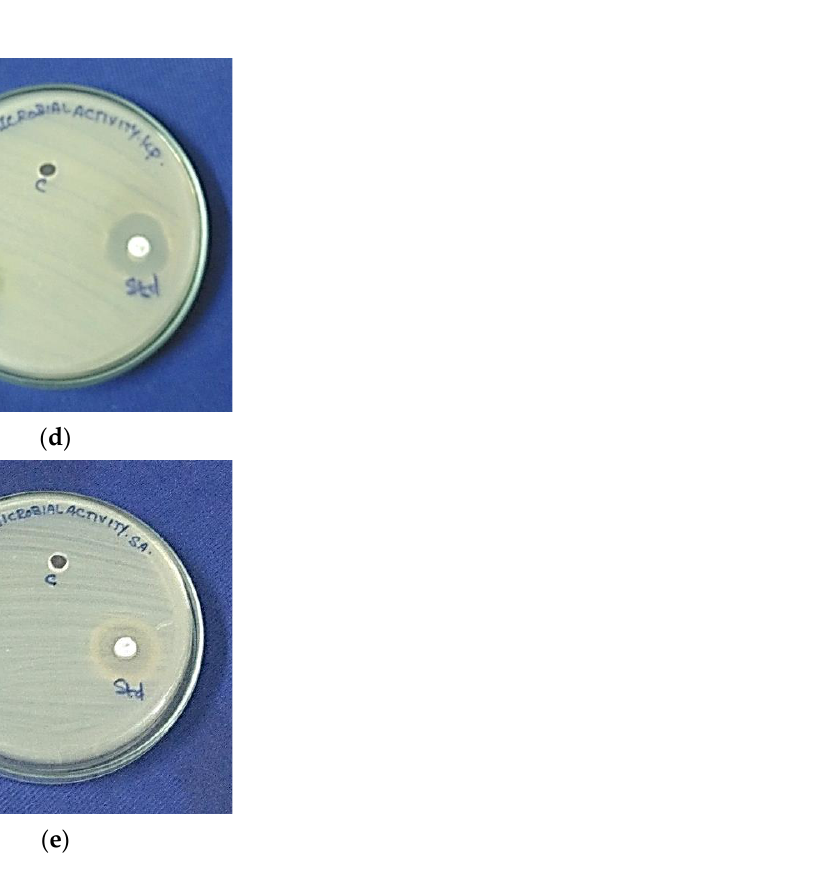
Figure 7. Antibacterial activity of Ni 2+ -doped HApNPs treated against ( a ) S. flexneri , ( b ) E. coli , ( c ) P. aeruginosa , ( d ) K. pneumoniae and ( e ) S. aureus. C-Negative control (DMSO), Std.-Positive control (Amikacin), 7- Ni 2+ -doped HApNPs. Table 1. Zone of inhibition of Ni 2+ -doped HApNPs against bacterial pathogens. Zone of Inhibition (mm) Samples